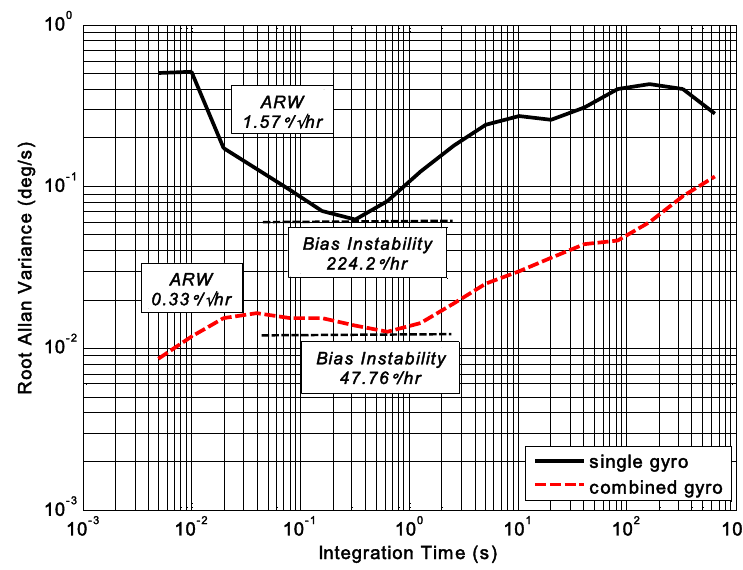
Figure 12. FFT plot of combined angular rate signal compared to the single gyroscope.